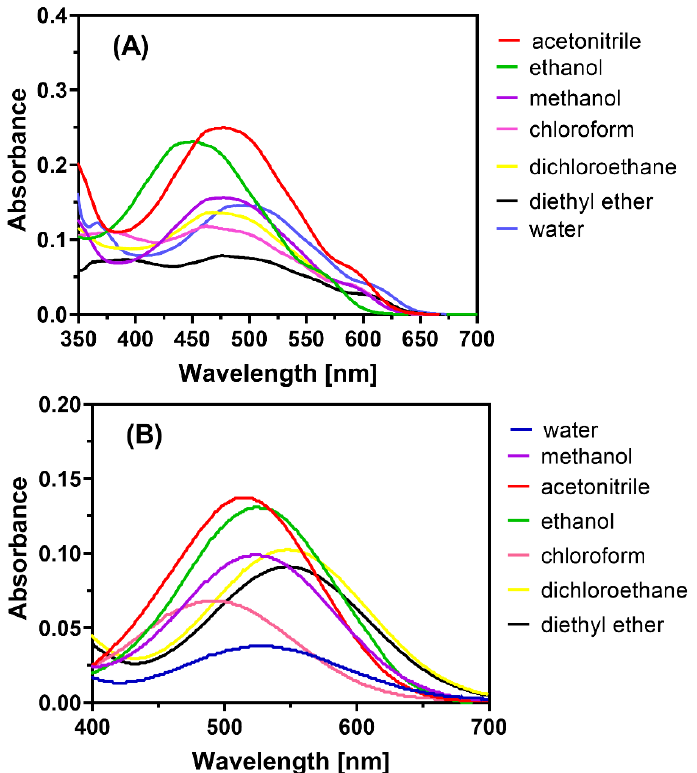
Figure 2. Effect of solvent on the absorption spectrum of the complexes of LGN 50 with ( A ) DDQ and ( B ) CHA.